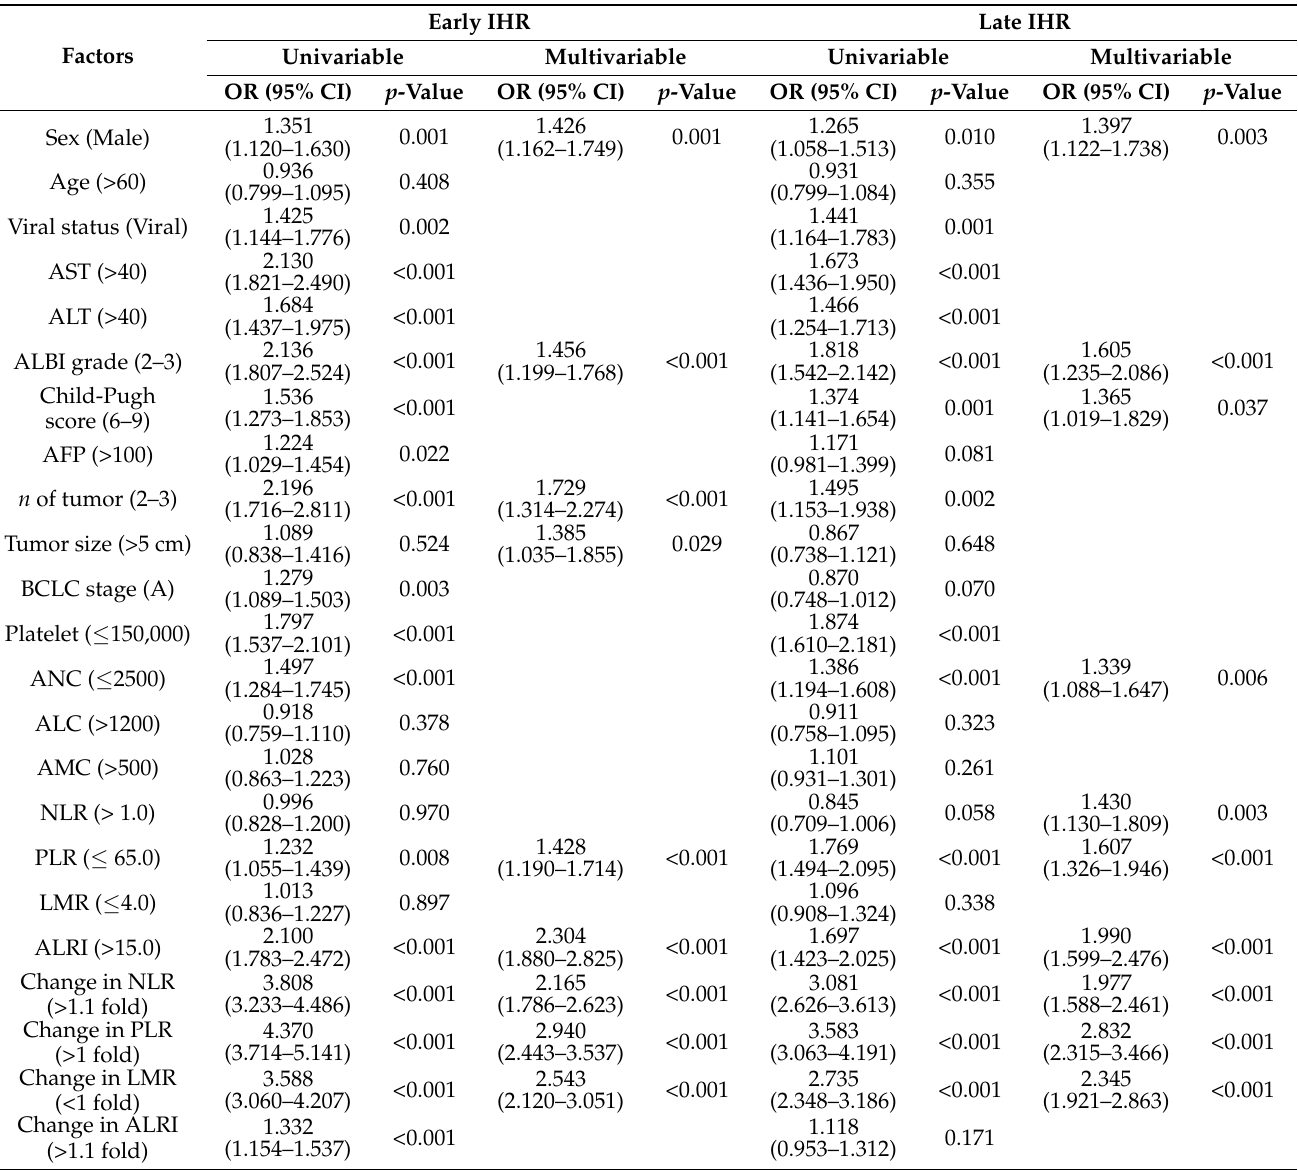
Table 3. Univariable and multivariable results of binary logistic regression analysis for potential factors of early and late intrahepatic